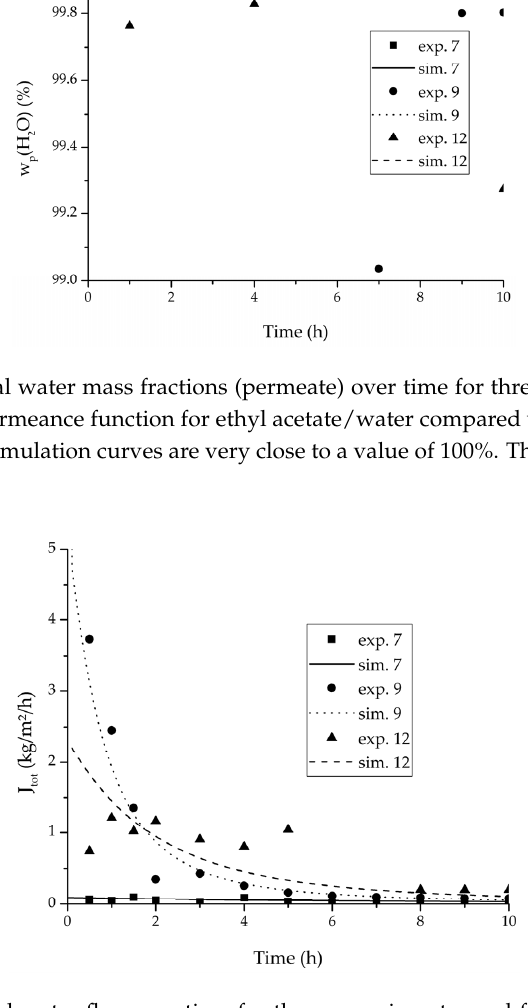
Figure 13. Experimental water flux over time for three experiments used for the validation of the permeance function for ethyl acetate/water compared with the corresponding simulation result. Membranes 2018 , 8 , 4